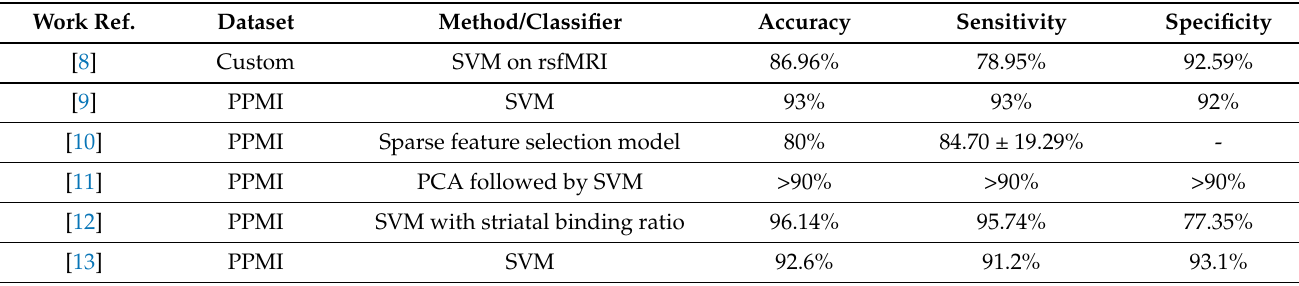
Table 1. A comparative study of some past methods related to the proposed work. Work